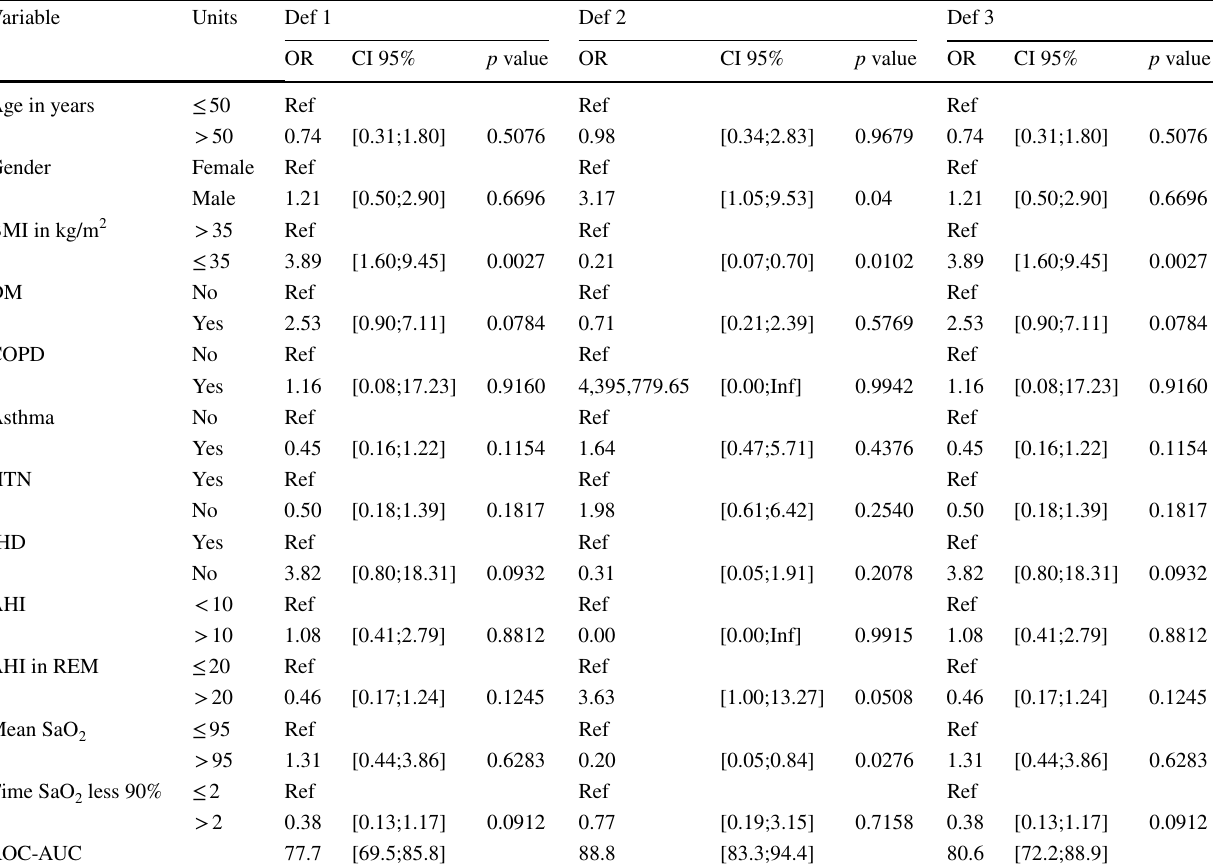
Table 7 Multivariate analysis using logistic regression